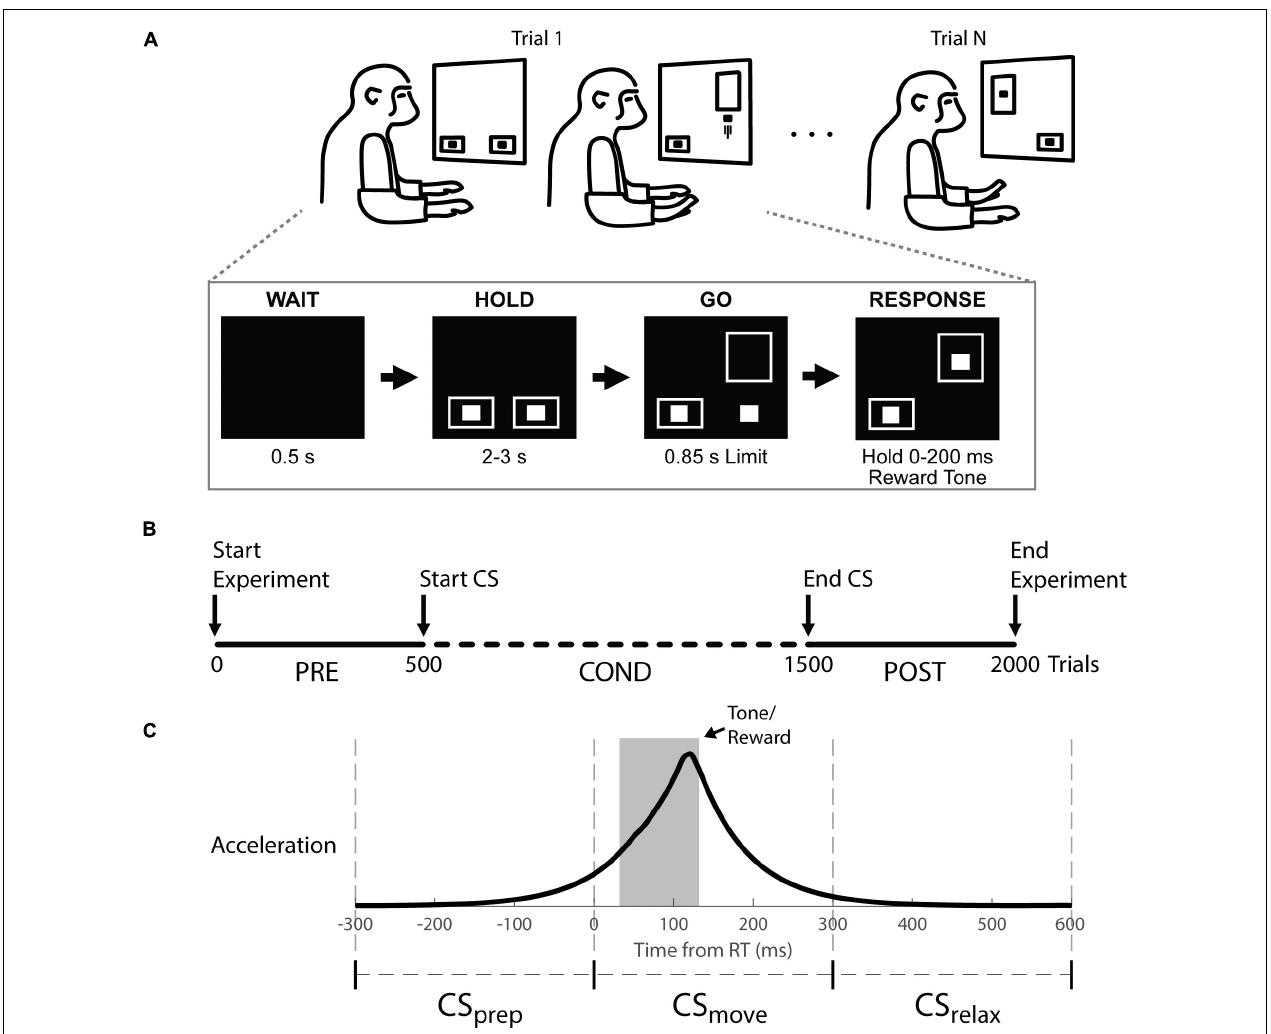
FIGURE 2 | Behavioral task, experimental timeline, and stimulus timing. (A) Top: Monkeys were cued to move a cursor into a target box by rapid wrist extension. Trials were randomly selected to be left or right. Bottom: example right hand trial. (B) Experimental timeline showing trials before (Pre), during (Cond) and after (Post) cortical stimulation (CS). The task was performed continuously throughout the experiment. (C) Stimulus timings are shown with respect to the average accelerometer trace across trials. The stimulus timing was split into three groups relative to movement onset (RT at 0): CS prep , CS move , and CS relax .